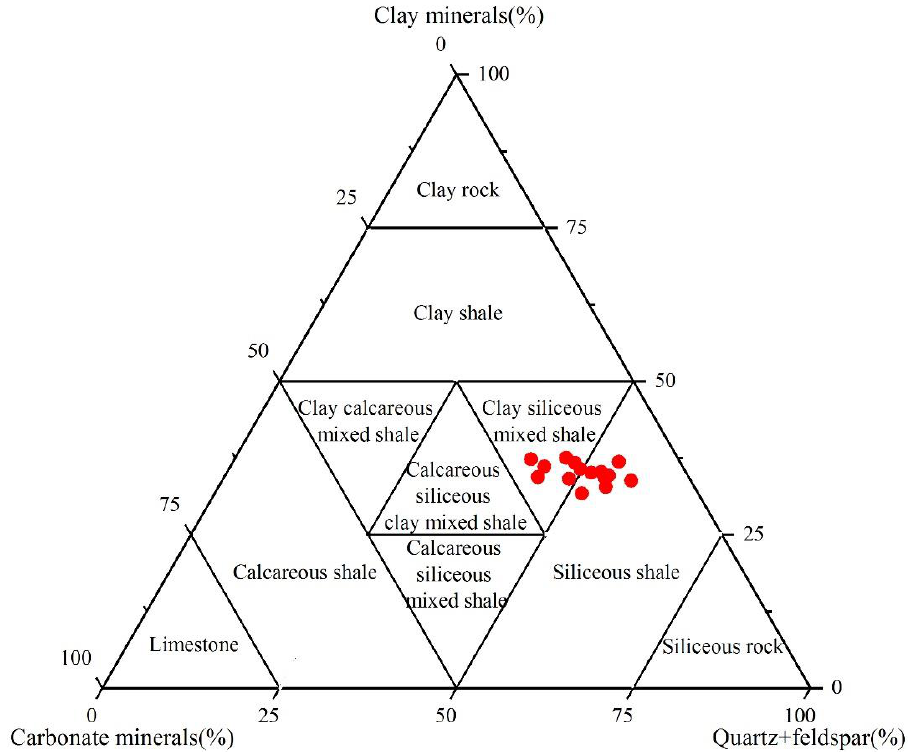
Figure 4. The lithofacies division results of the Dalong Formation shale (base map cited from Wang et al., 2016) [43].